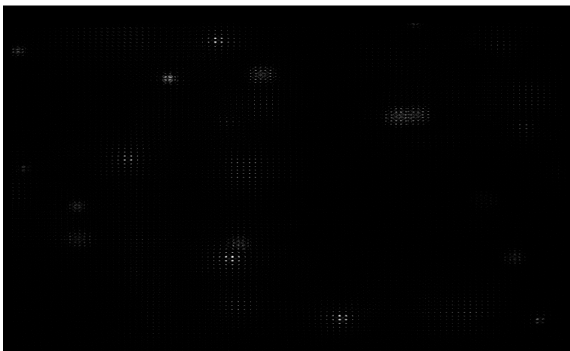
Figure 17. Registered light field of 6 μ m fluorescent beads in agar. The light field should appear as a grid of non-overlapping circles.